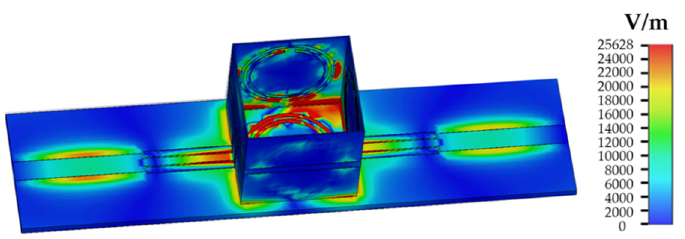
Figure 6. The electric field distribution of the sensor.